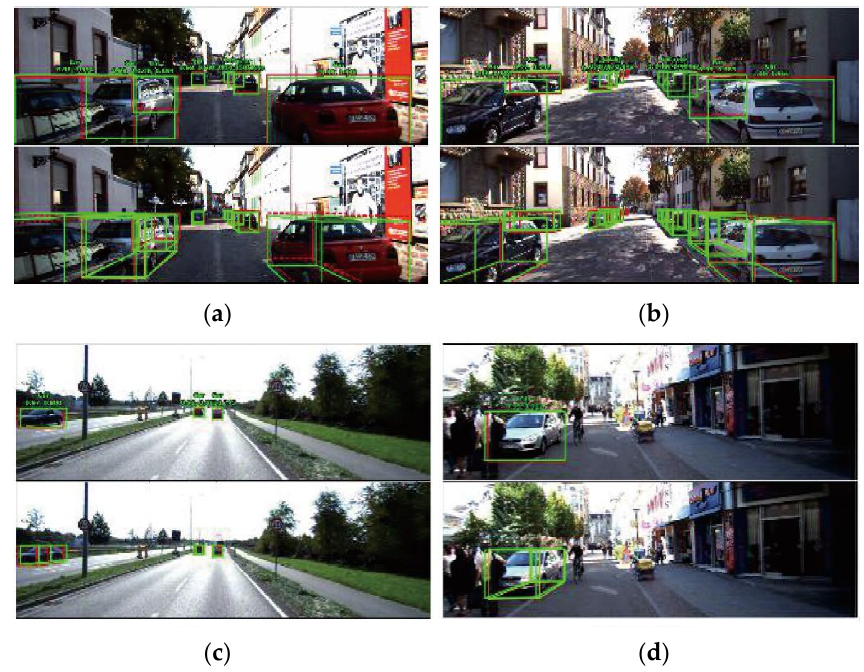
Figure 11. Natural scene experiment results: ( a ) one-way oncoming traffic; ( b ) two-way oncoming traffic; ( c ) wide road; and ( d ) narrow roads.